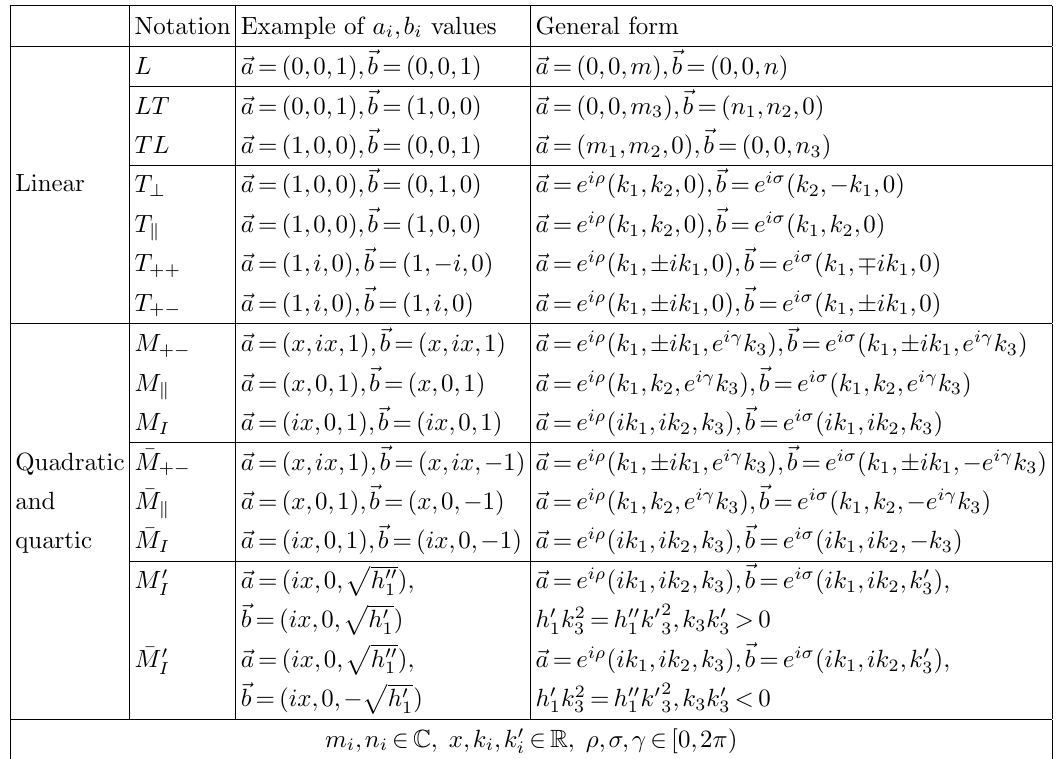
Table 1 . Notation for relevant polarisation con(cid:12)gurations. The L , LT , TL and T i cases lead to linear inequalities, while the M i and (cid:22) M i cases lead to higher order inequalities. We show example values of a i and b i , and in addition also give their general form in the last